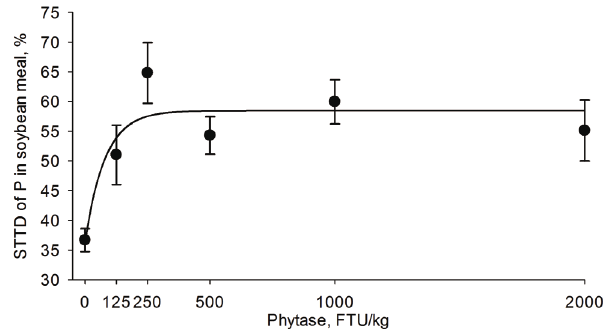
Figure 4. Fitted exponential model of standardized total tract digestibility (STTD) of P in soybean meal as a function of concentration of exogenous phytase in the diet. Treatment means ( ● ) and standard error are shown. STTD of P =36.3283+22.1438×[1–exp(–0.0126 ×phytase dose in FTU/kg)], r 2 = 0.80, p<0.001. The concentration of phytase needed to maximize (i.e., to obtain 95% of the upper asymptote) the STTD of P at 55.5% was calculated to be 160 FTU/kg. FTU, phytase